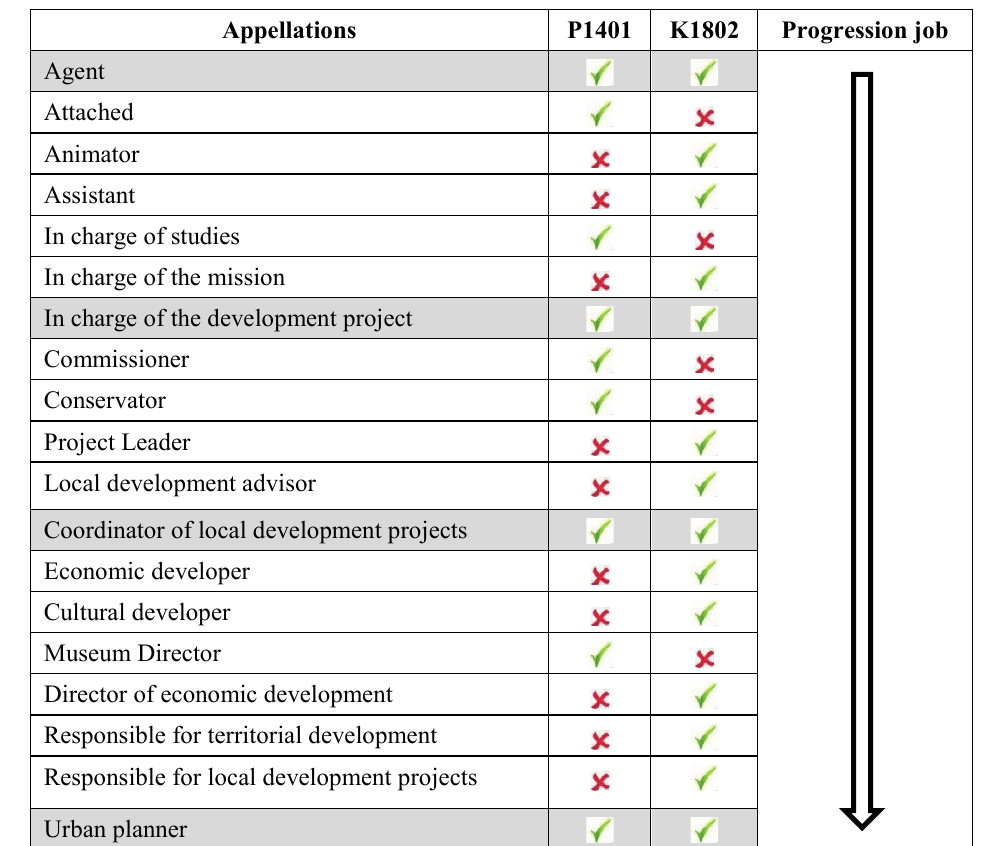
Table 5. Indicator Comparison by Appellations (P1401 and